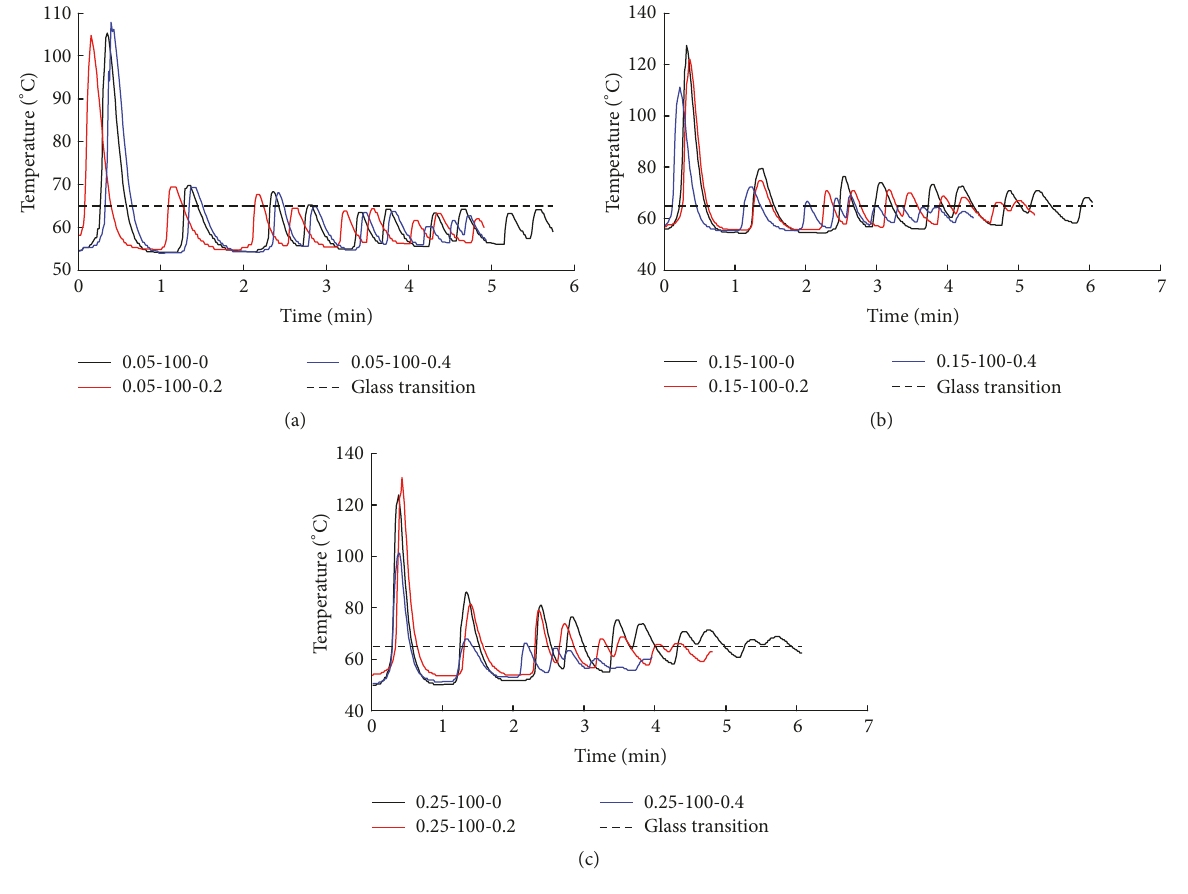
Figure 13: The temperature files under different levels of layer thickness and air gap. Table 5: The experiment results with the combined influence of deposition velocity and air gap. Factor Tensile